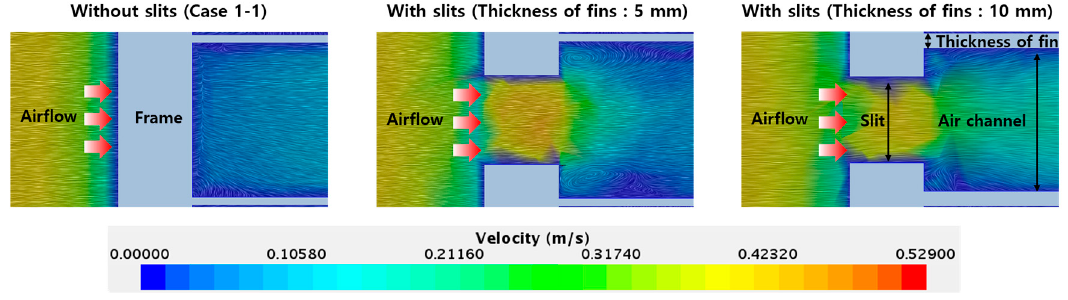
Figure 13. Vector of velocity with and without the slits.